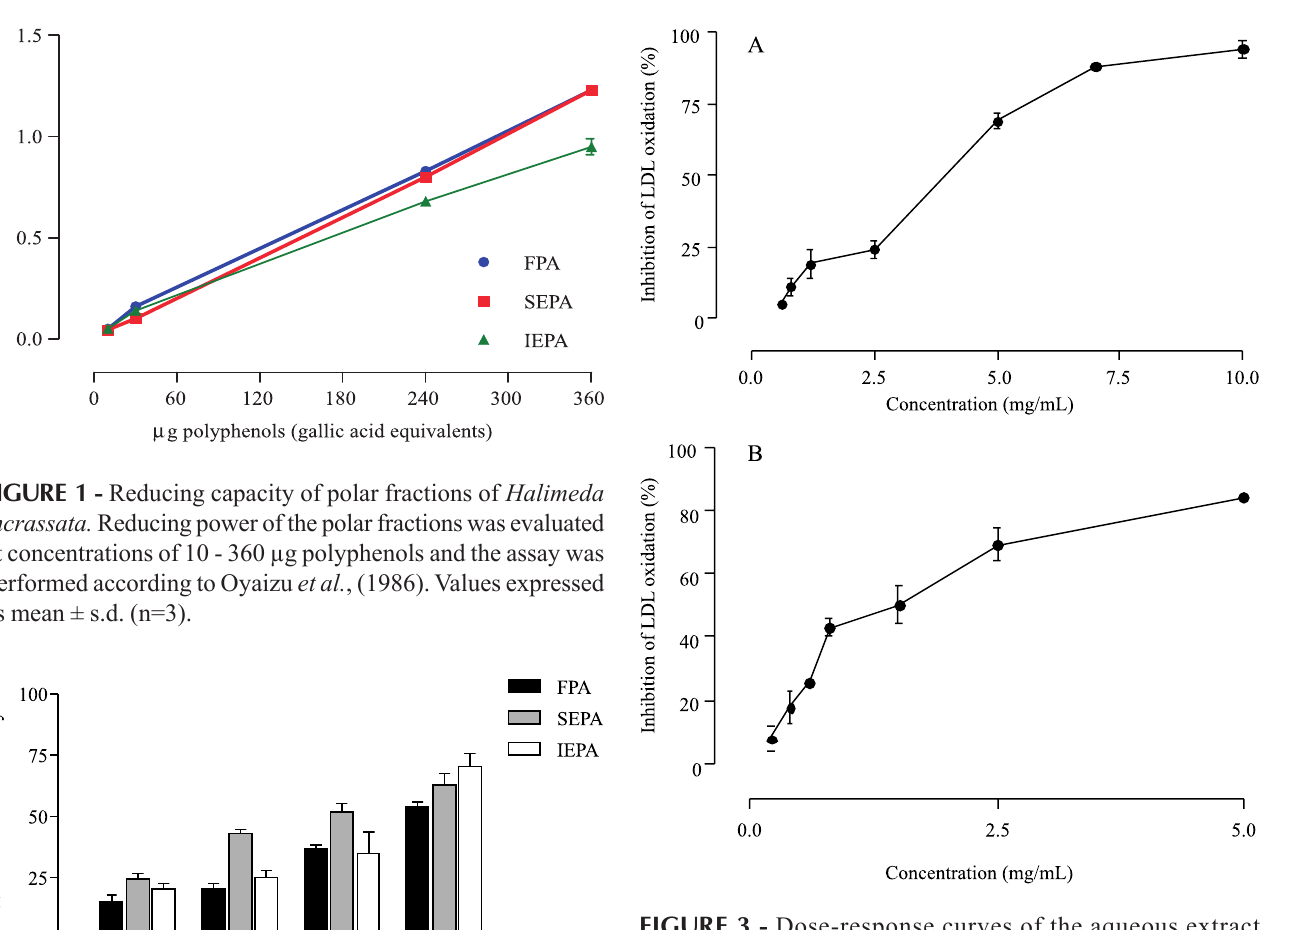
FIGURE 3 - Dose-response curves of the aqueous extract of Halimeda incrassata on inhibition of lipoperoxidation in hep-LDL oxidation mediated by Cu 2+ 10 µM (A) or AAPH 20 mM (B). H. incrassata concentration is expressed in log concentration of aqueous extract (1 mg lyophilized is equivalent to 0.02 g dry seaweed containing 2.183 ± 0.134 µg GAE/mg lyophilized aqueous extract. Values represent mean ± s.d. (n=3). ) 50 . TABLE II - Effect of Halimeda incrassata on LDL oxidation in cell free